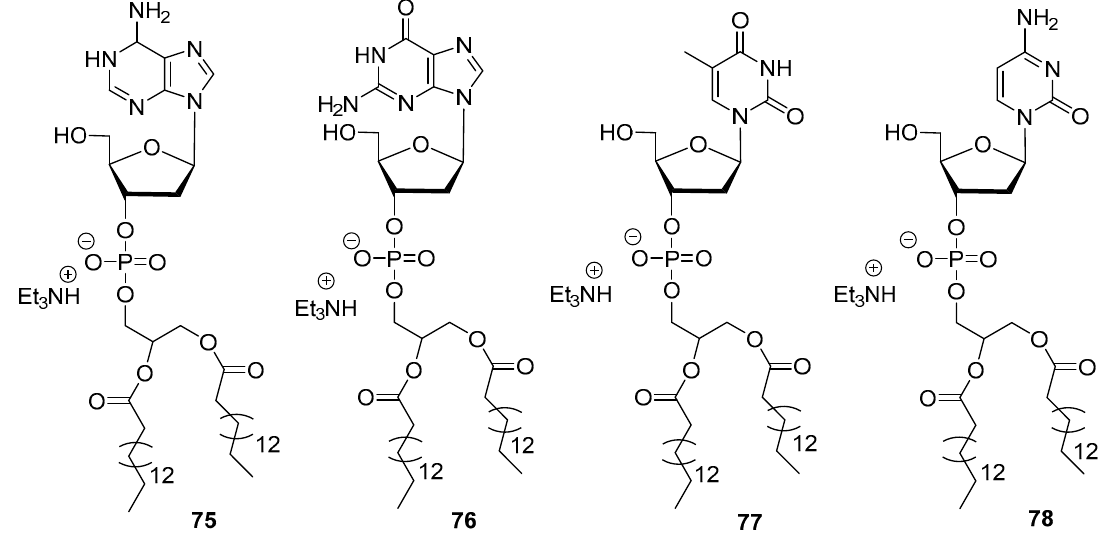
Figure 46. Cytidine- and guanosine-based nucleotide–lipids [94].